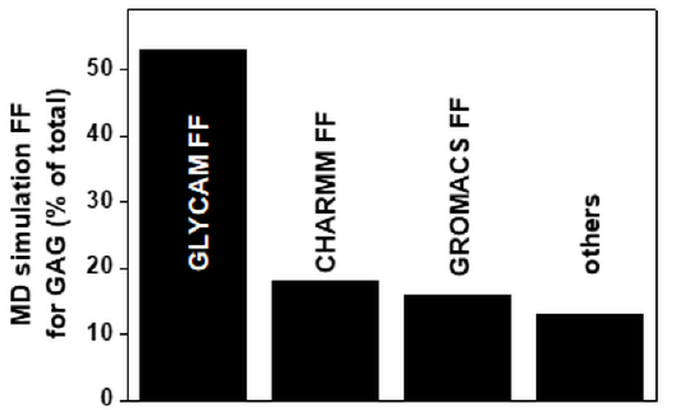
Figure 6. FFs used for MD simulations of GAGs alone or in complexes with targets. Each bar reports the percentage of papers in which the indicated FFs have been employed. For the FFs grouped under “others”, see Table 2. For further details on the bibliographic research strategy, see Appendix A.